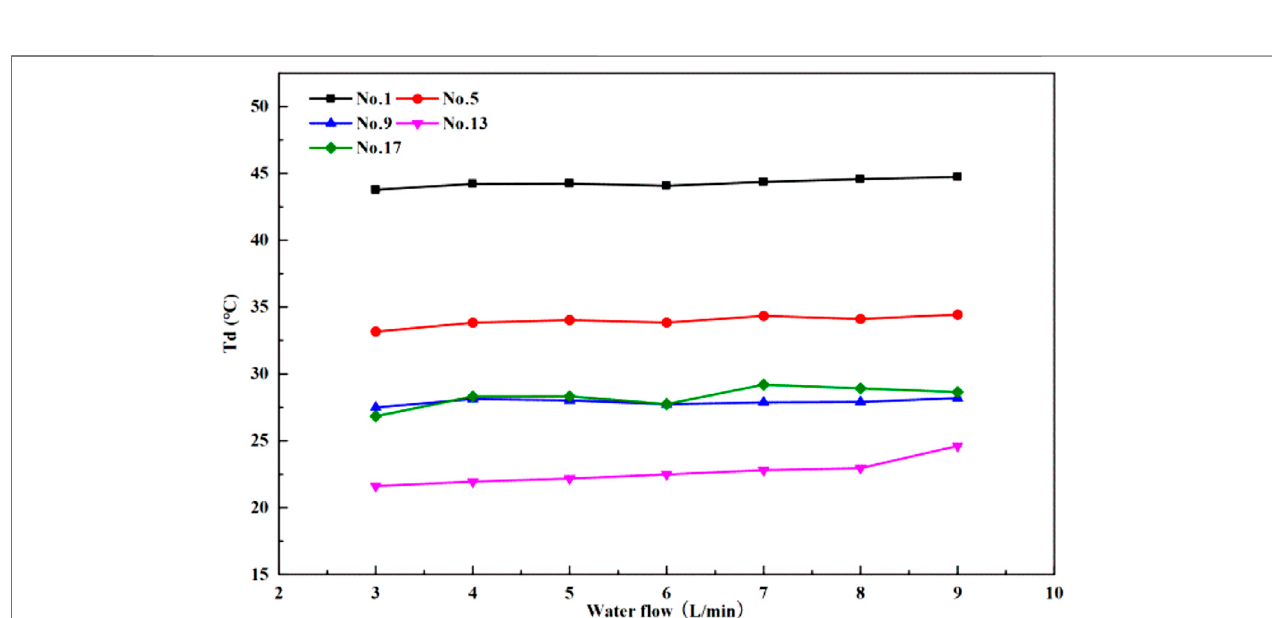
FIGURE 14 | Td curves with air fl ow in different